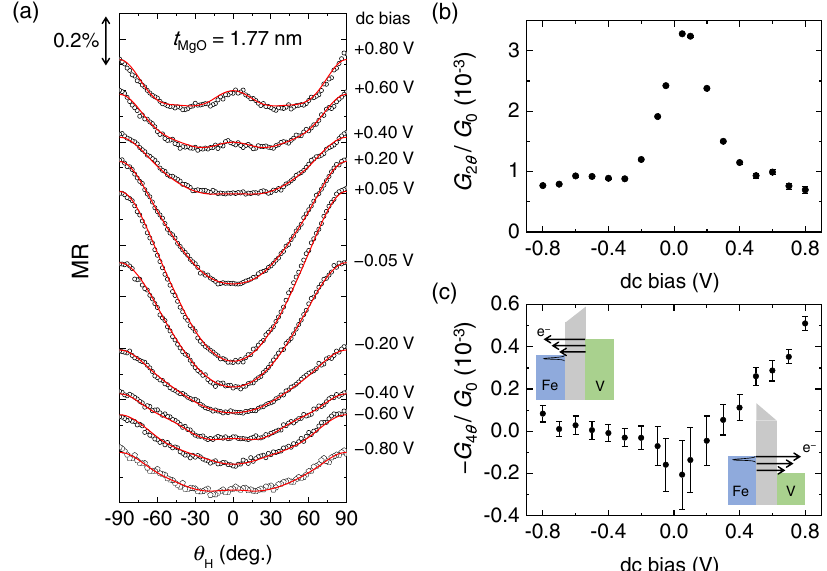
FIG. 5. (a) The dc-bias-voltage dependence of TAMR. Black circles and red curves are experimental data and fitting curves using Eq. 4, respectively. (b) Twofold component of the TAMR. (c) Fourfold component of the